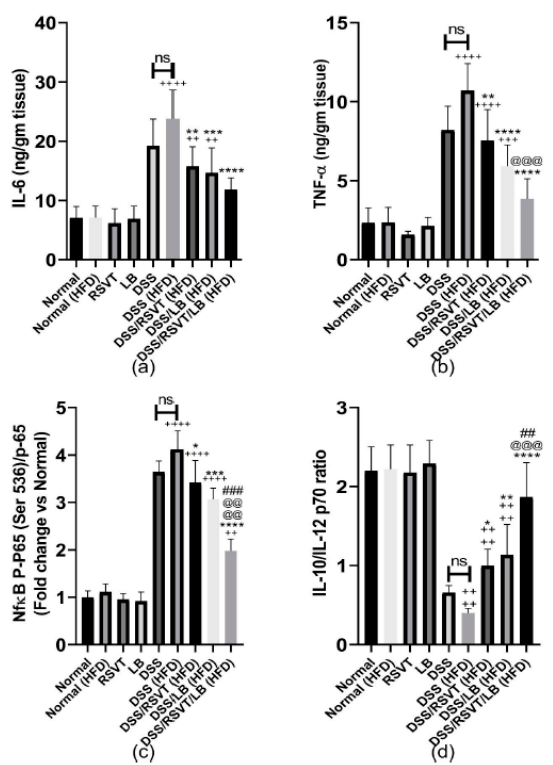
Figure 8. Effect of rosuvastatin (RSVT), Lactobacillus (LB), and their combined therapy on ( a ), IL-6; ( b ), tumor necrosis factor alpha (TNF- α ); ( c ), NF- κ B p-p65 (Ser 536)/p65; and ( d ), IL-10/IL-12 P70. ++, p < 0.01 vs. Normal (HFD); +++, p < 0.001 vs. Normal (HFD); ++++, p < 0.0001 vs. Normal (HFD); *, p < 0.05 vs. DSS (HFD); **, p < 0.01 vs. DSS (HFD); ***, p < 0.001 vs. DSS (HFD); ****, p < 0.0001 vs. DSS (HFD); ##, p < 0.01 vs. DSS/LB (HFD); ###, p < 0.001 vs. DSS/LB (HFD); @@@, p < 0.001 vs. DSS/RSVT (HFD); @@@@, p < 0.0001 vs. DSS/RSVT (HFD); ns,